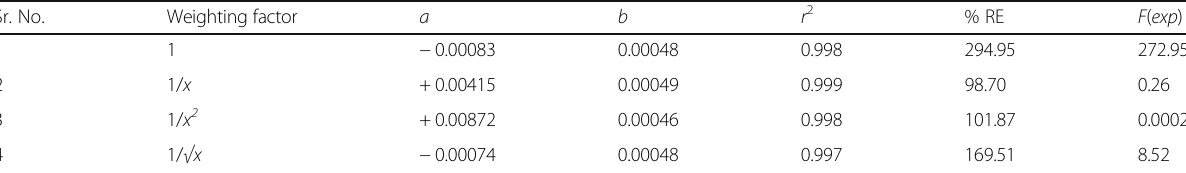
Table 3 Regression parameters for unweighted and weighted regression with different weighting factors Sr.